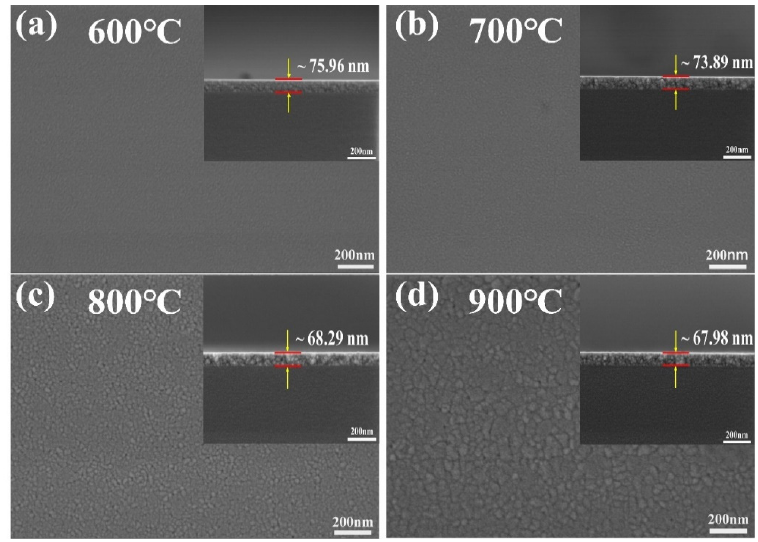
Figure 10. ( a – d ) are SEM images of AZO films at 600, 700, 800, and 900 °C, respectively, and the insets indicate the cross-sectional images of the films.